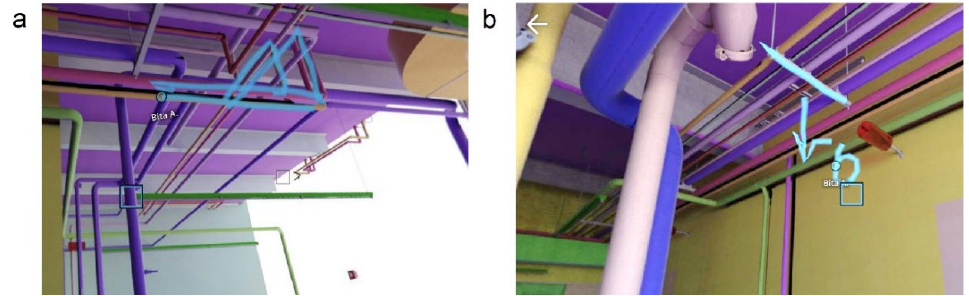
Figure 3. Screenshots of the recorded message in VR, explaining: ( a ) Clash 1; ( b ) Clash 2.